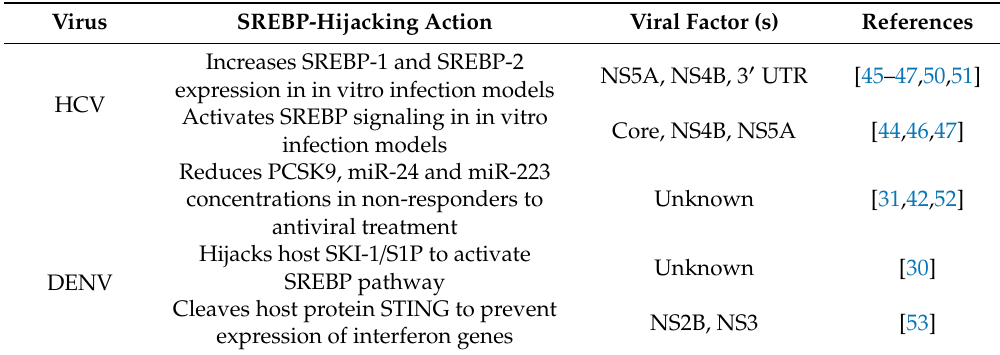
Table 2. Hepatitis C virus (HCV) and dengue virus (DENV) components involved in hijacking of the host sterol regulatory element-binding protein (SREBP) pathway for viral